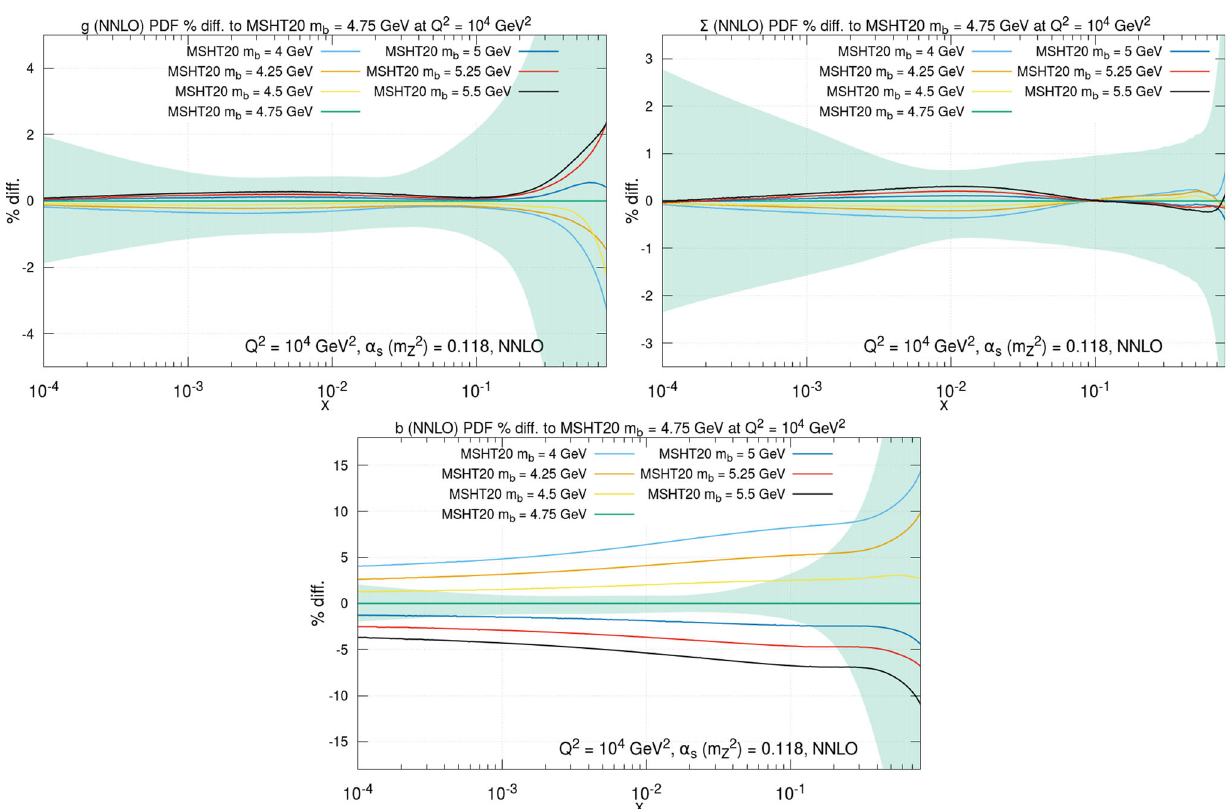
Fig. 26 The m b dependence of the gluon, light-quark singlet and bottom distributions at NNLO for Q 2 = 10 4 GeV 2 , compared to the standard MSHT20 distributions with m c = 1 . 4 GeV and m b = 4 . 75 GeV Table 7 Predictions for W ± and Z cross sections (in nb), including leptonic branching, obtained with the NNLO MSHT20 parton sets. The PDF uncertainties and m c and m b variations are shown, where the m c variation corresponds to ± 0 . 15 GeV and the m b variation corresponds to ± 0 . 5 GeV, i.e. about 10% in each